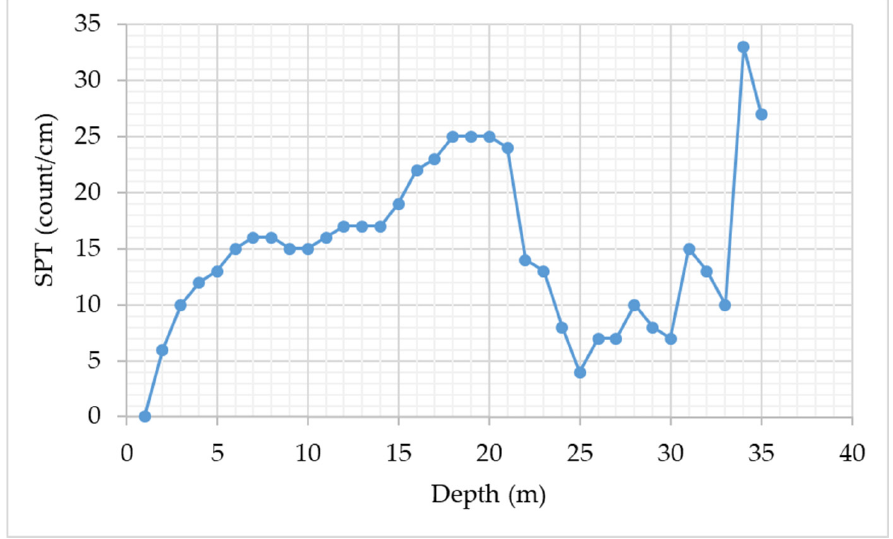
Figure 5. Standard penetration test results [9].